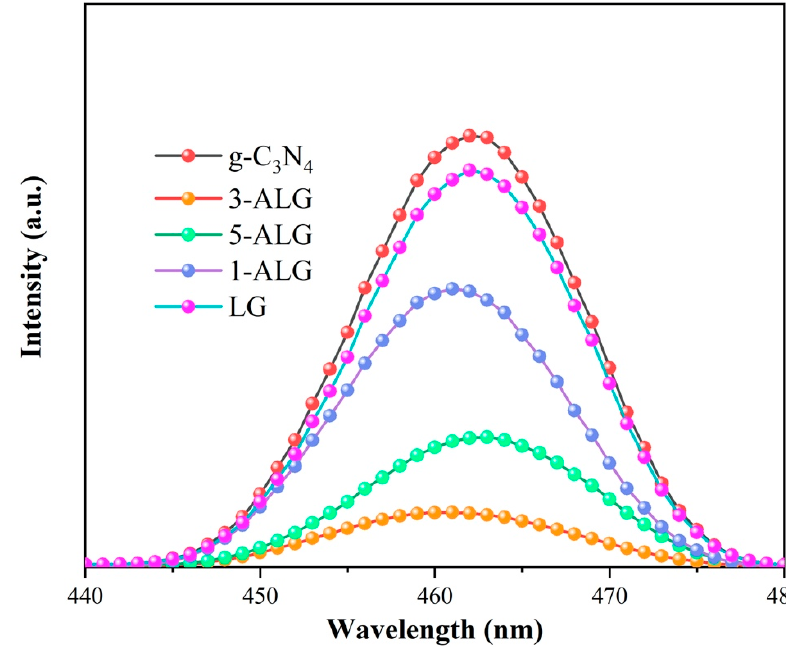
Figure 7. PL spectra of g-C 3 N 4 , LG, and 3-ALG.